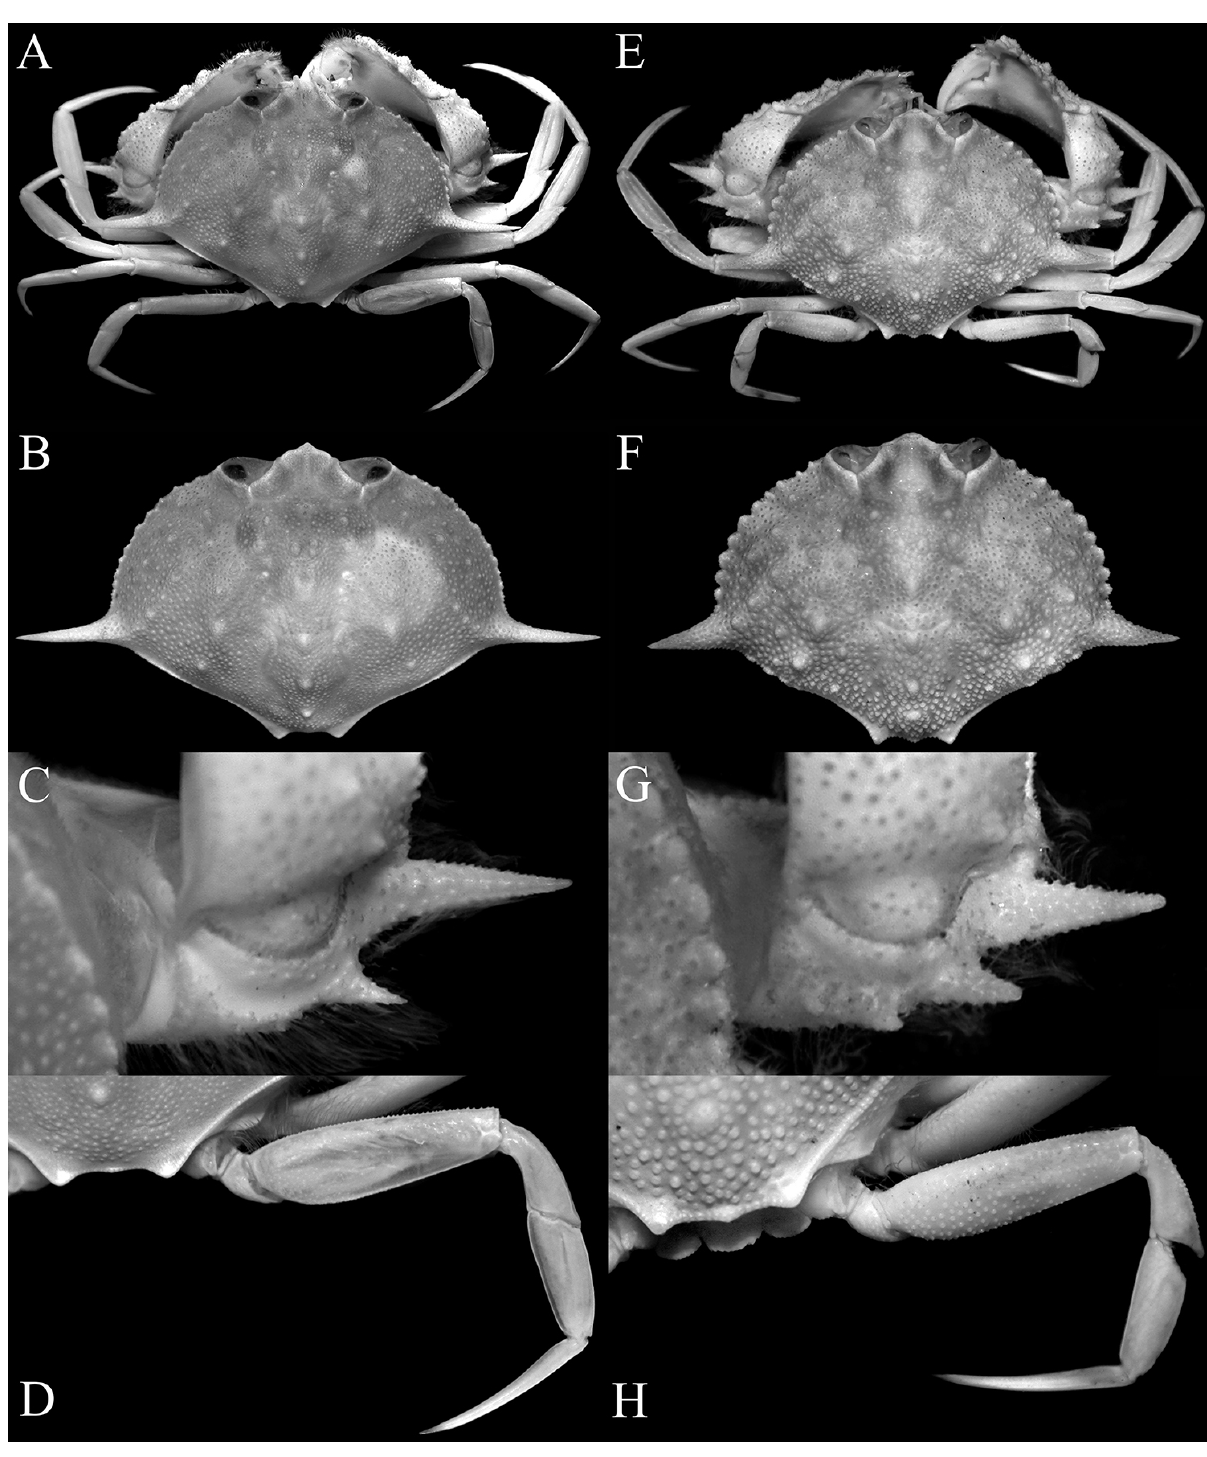
Figure 2. A – D , Mursia bicristimana Alcock and Anderson, 1894, young male (37.2 × 19.6 mm) (ZRC 2017.0134), E – H , M. spiridonovi Karasawa, 2018, male (23.9 × 14.6 mm) (ZRC 2019.0492). A , E , overall dorsal view; B , F , dorsal view of carapace; C , G , dorsal view of right distal margin of merus of right cheliped; D , H , posterior carapace margin and right fourth ambulatory